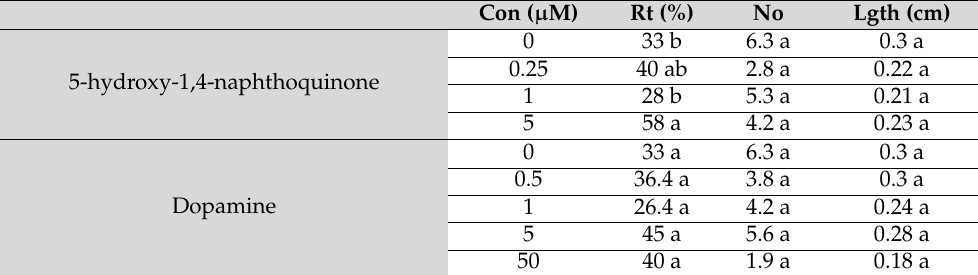
Table 1. Effect of dopamine and 5-hydroxy-1,4-naphthoquinone on rooting variables of explants cultivated in rooting medium without IBA.